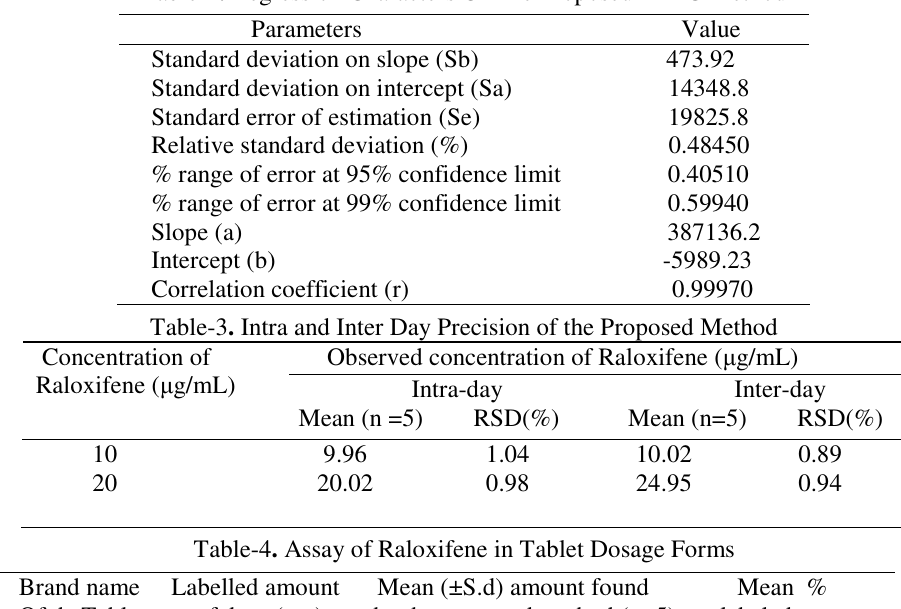
Table-2 . Regression Characters Of The Proposed HPLC Method